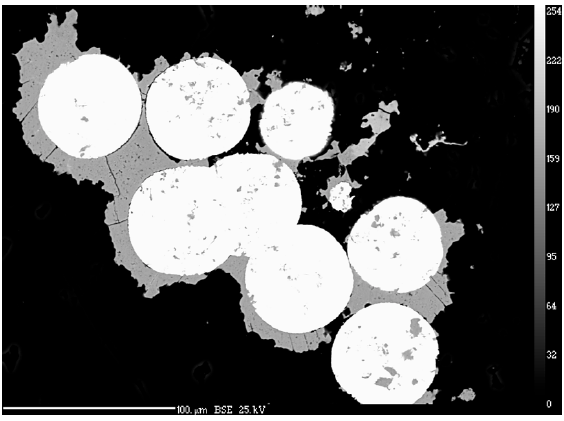
Figure 11. Spherical aggregates of uraninite (white) overgrown by later berzelianite (grey). Backscattered electron (BSE in the further text) photo. P ř íbram, a dump of shaft 16. Photo by J. Sejkora and P. Škácha.